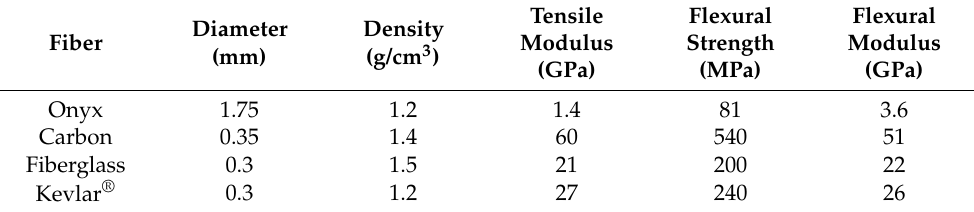
Table 1. Basic properties of the materials.